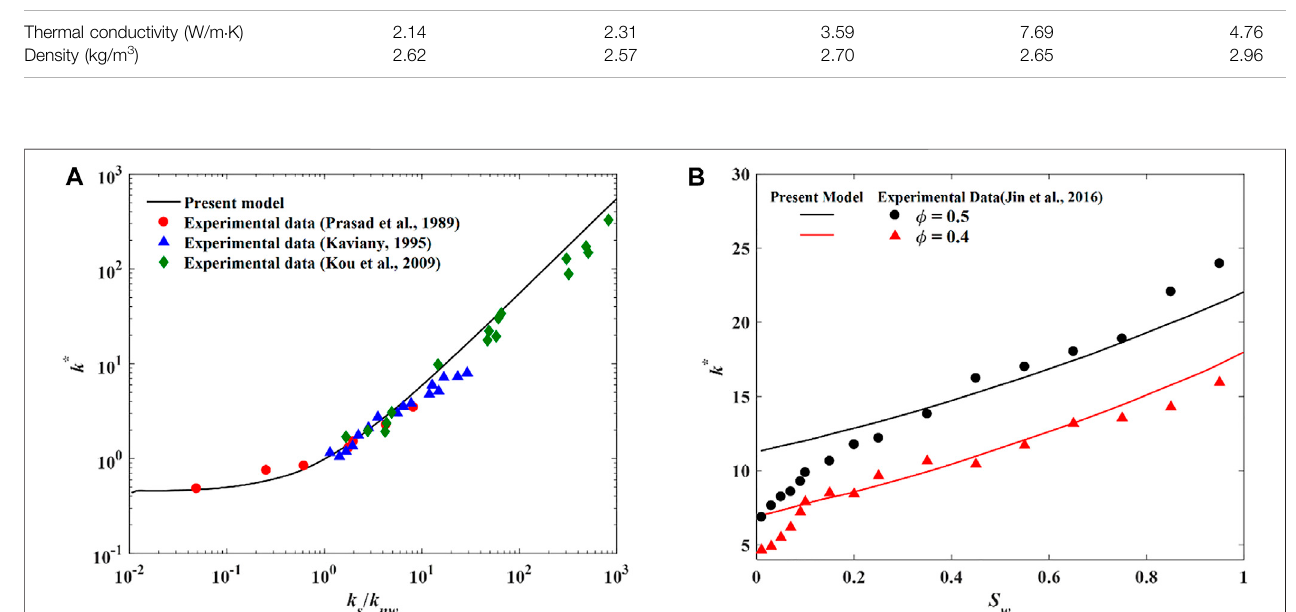
FIGURE 4 | The comparison between proposed model prediction and experimental data. (A) k_s/k_{nw} vs. k ^ *; (B) S_w vs. k ^ *.